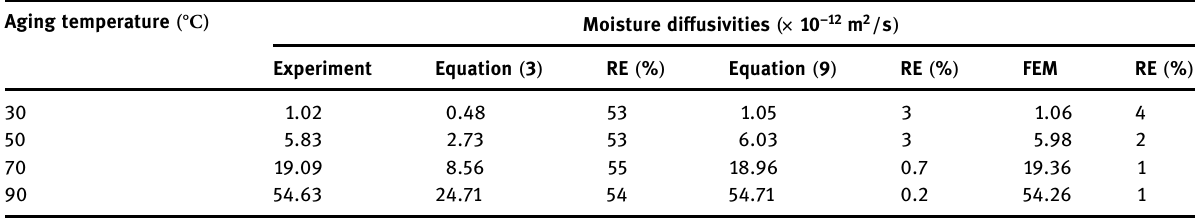
Table 2: Comparison of water di ff usivities obtained by experimental data, the classical Halpin – Tsai equation ( equation ( 3 )) , and the modi fi ed Halpin – Tsai equation ( equation ( 9 )) in the CF/PA6 ( SYT49S - 12K ) composites. Here RE ( % ) denotes the relative error Aging temperature ( ℃ )